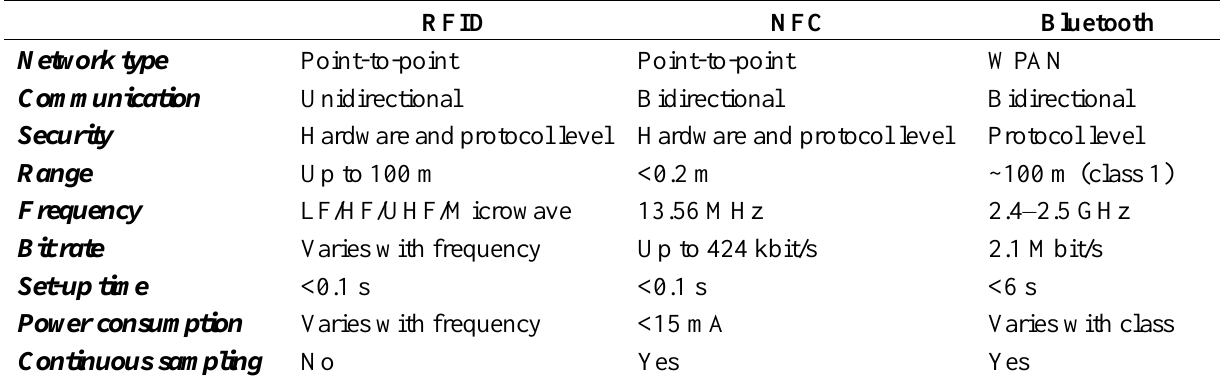
Table 1. RFID vs . NFC vs . Bluetooth.